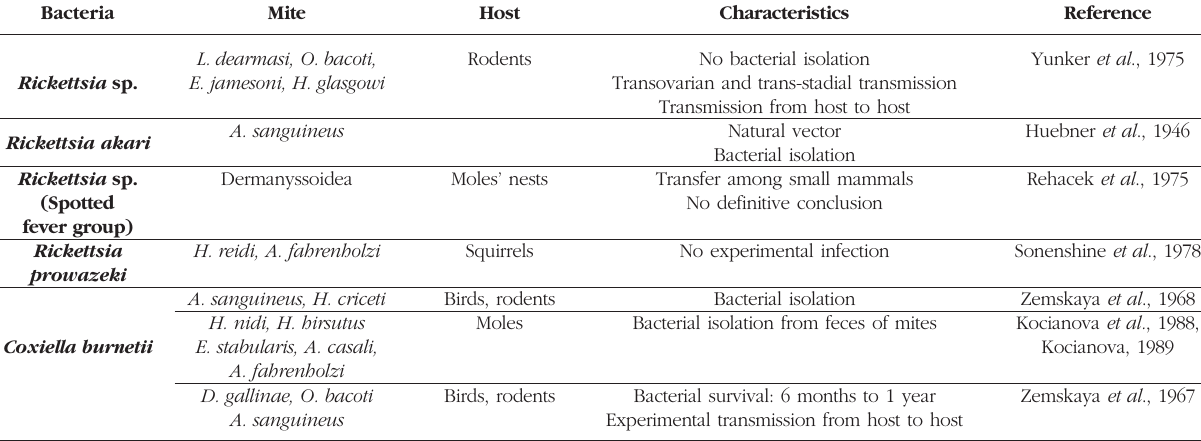
Table VI. – Rickettsia and Coxiella transmitted by dermanyssoid mites. ( A. casalis = Androlaelaps casalis , A. fahrenholzi = Androlaelaps fahrenholzi , A. sanguineus = Allodermanyssus sanguineus , E. jamesoni = Eubrachylaelaps jamesoni , E. stabularis = Eulaelaps stabularis , H. criceti = Haemogamasus criceti , H. glasgowi = Haemolaelaps glasgowi , H. hirsutus = Haemogamasus hirsutus , H. nidi = Haemoga- masus nidi , H. reidi = Haemogamasus reidi , L. dearmasi = Laelaps dearmasi , O. bacoti = Ornithonyssus bacoti